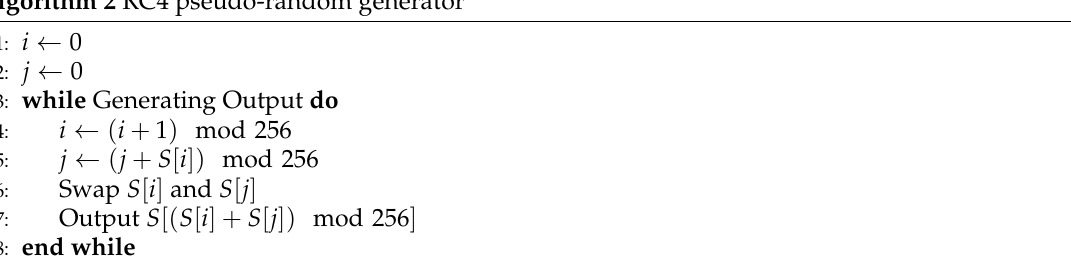
Algorithm 2 RC4 pseudo-random